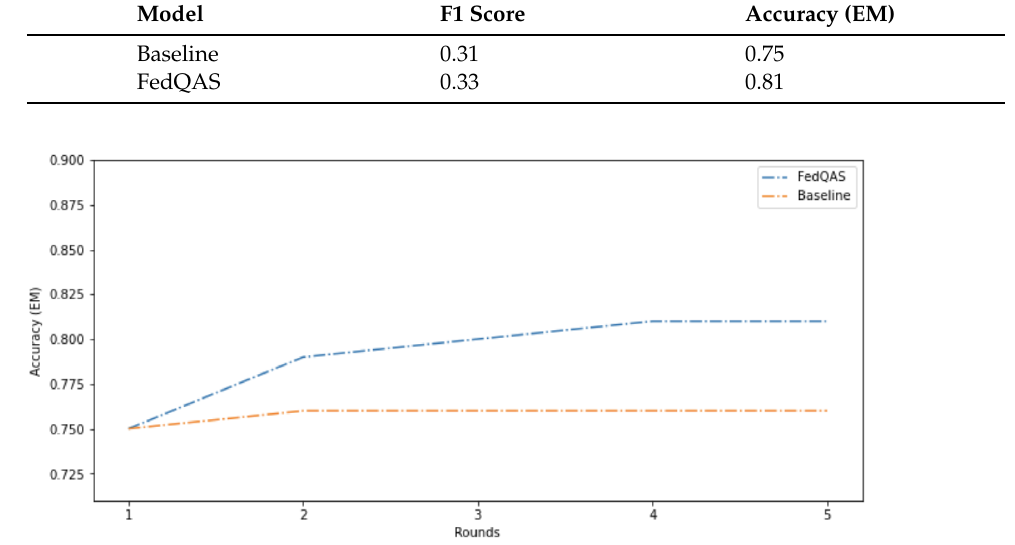
Figure 5. Convergence of accuracy (Exact Match) on the SQUAD dataset with 1 combiner, 5 clients and 5